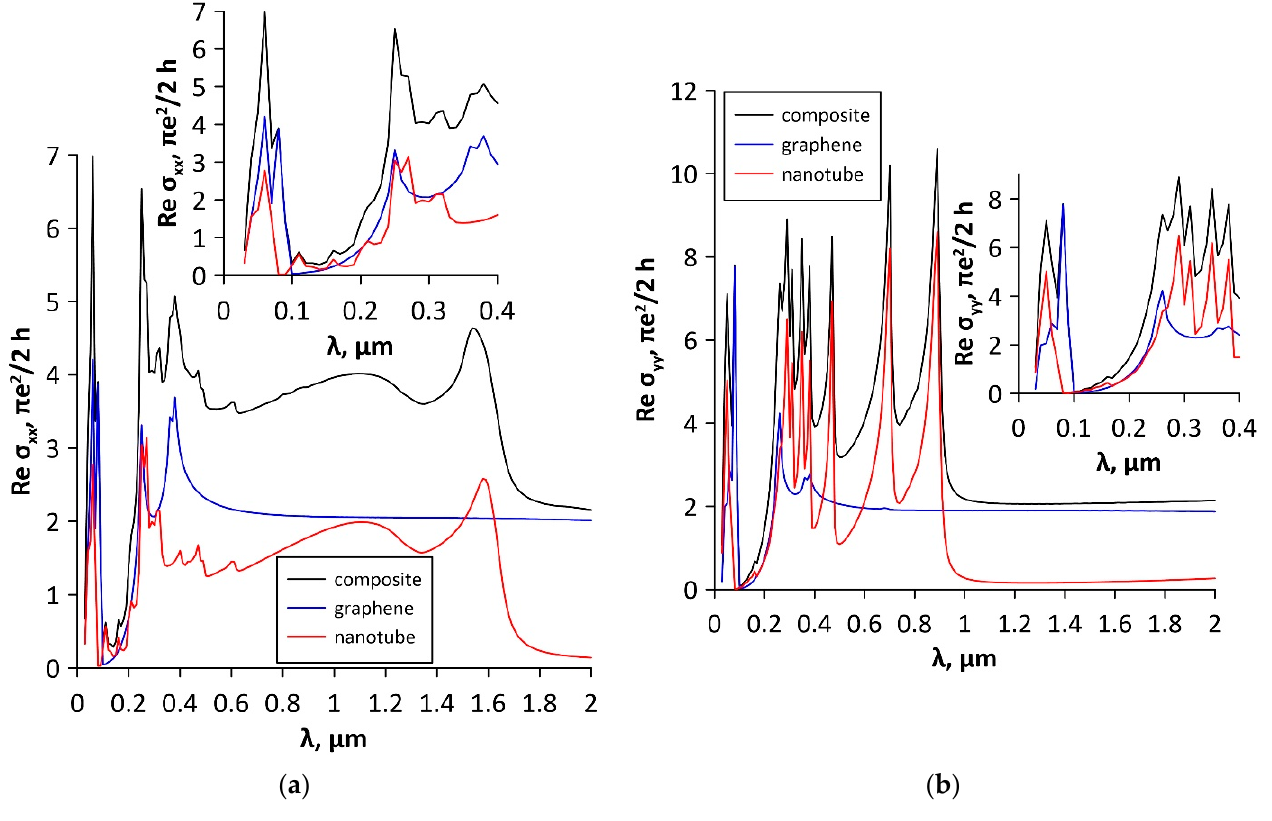
Figure 4. Profiles of the real part of the diagonal elements of the optical surface conductivity tensor for topological model V3 of a graphene-SWCNT (12,6) composite film: ( a ) with polarization along the X axis; ( b ) with polarization along the Y axis.